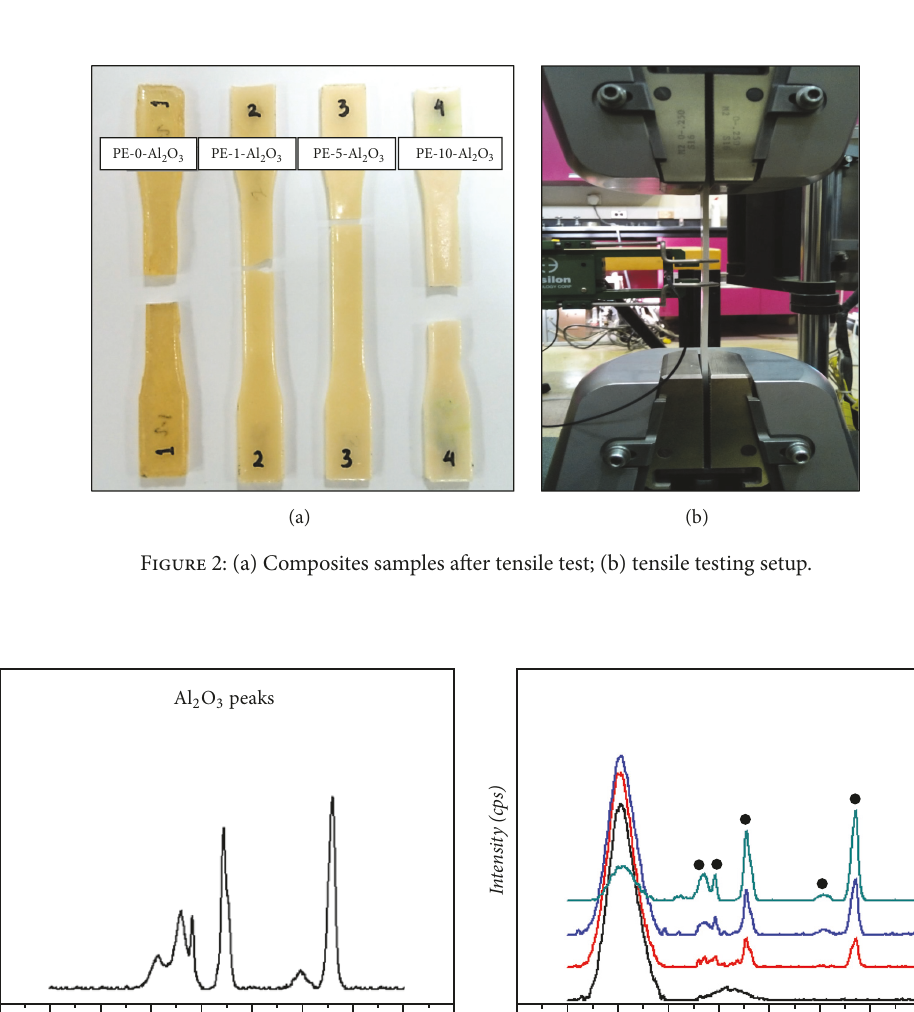
Figure 1: Flowchart of composites fabrication steps.